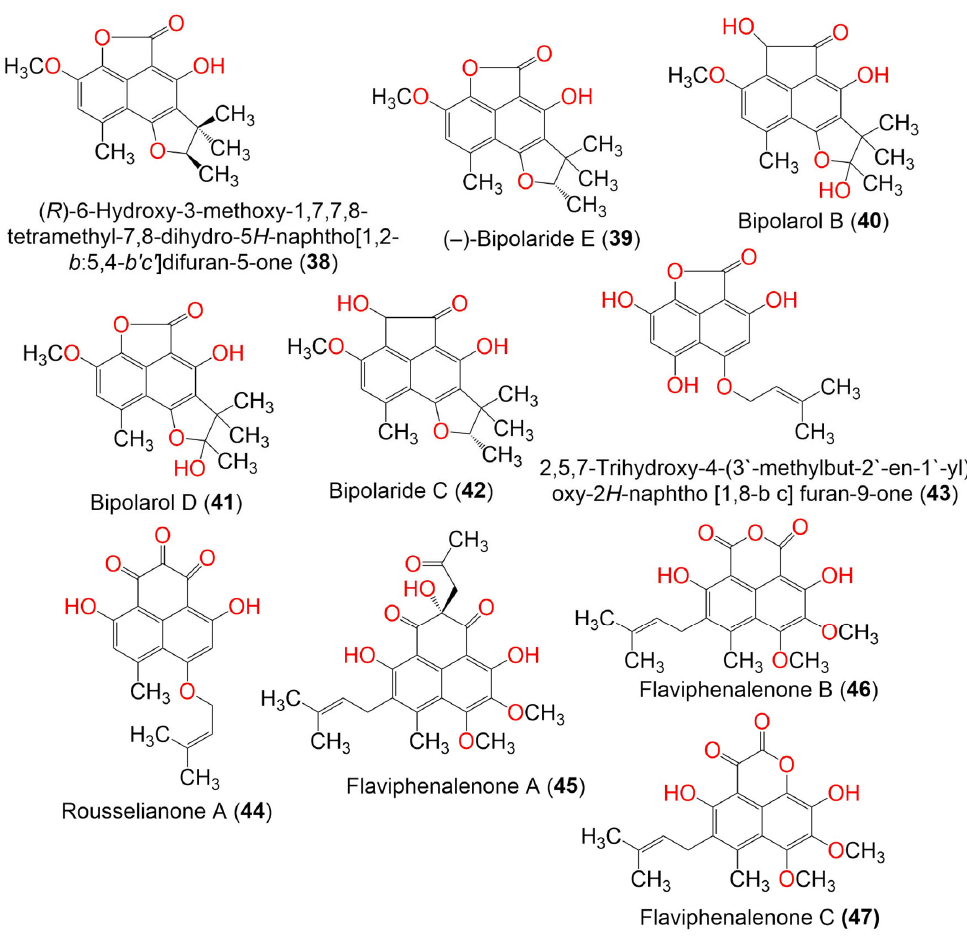
Figure 4. The structures of compounds 38 – 47 . Auxarthrones A–E ( 49 – 53 ) and FR ‐ 901235 ( 54 ) were obtained from the culture of the coprophilous fungus Auxarthron pseudauxarthron TTI ‐ 0363 (Figure 5). Compounds 52 and 53 possessed an unusual 7a,8 ‐ dihydrocyclopenta[ a ]phenalene ‐ 7,9 ‐ dione ring system. Compound 49 was separated into a mixture of racemic diastereomers; their structures were confirmed by X ‐ ray crystallography. Compounds 49 and 51 showed moderate antifungal potential toward C. albicans and C. neoformans (MICs 6.4 and 3.2 μ g/mL, respectively), compared to amphotericin B (MIC 0.8 μ g/mL). The other phenalenones